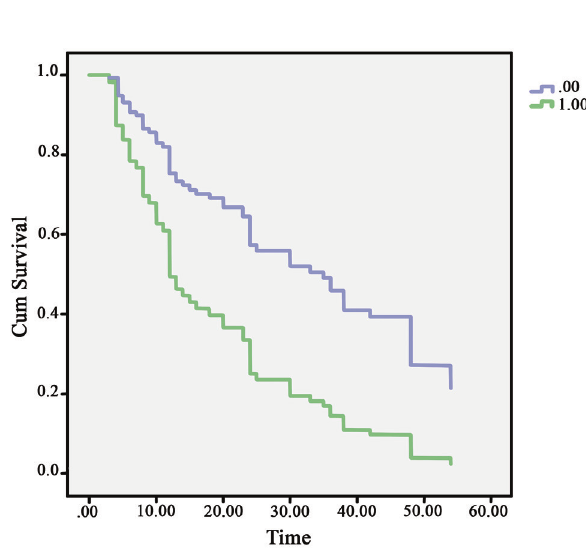
Figure 2 . Survival curve of patients according to gastric tu- mor stage. A significant difference was found between tumor stages 1&2 (Mean survival time= 35.5±3.2) and tumor stages 3&4 (Mean survival time= 17.9±2.3). P <0.001 [.00: tumor stages 1&2 1.00: tumor stages 3&4]